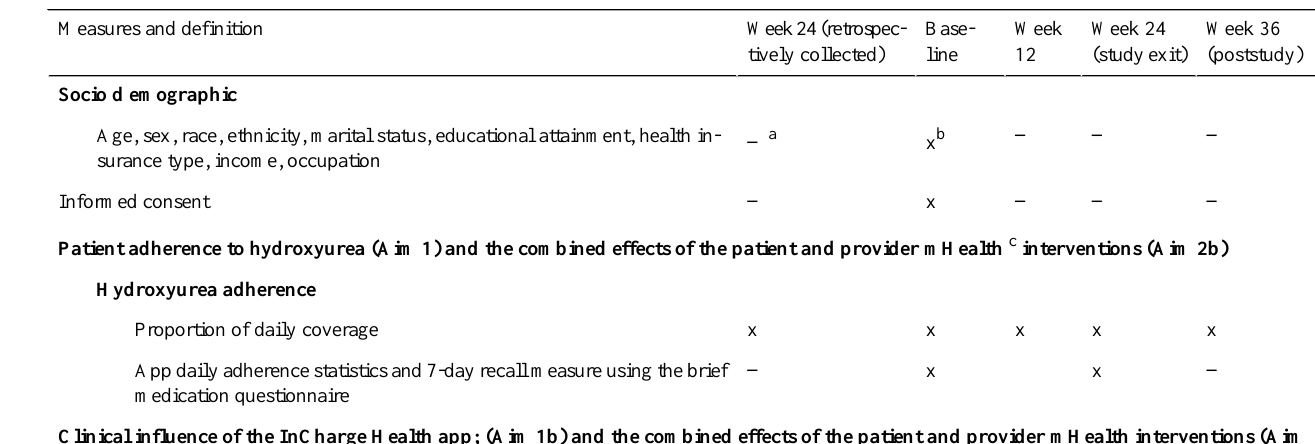
Table 1. Schedule of evaluations for patient